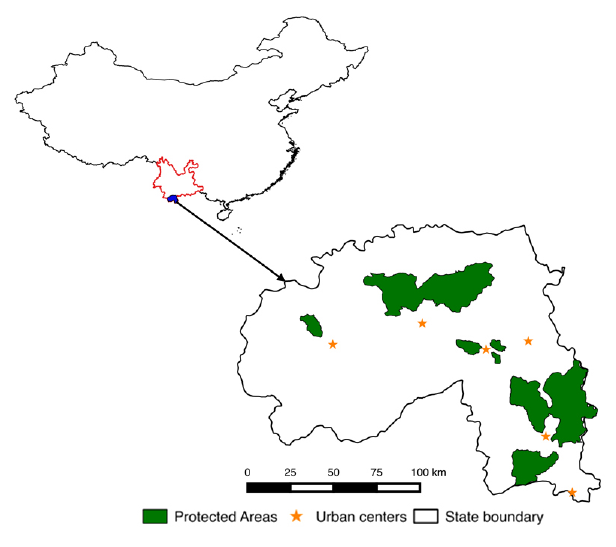
Fig. 1 . A map of Xishuangbanna Dai Autonomous Prefecture (inset; henceforth, Xishuangbanna). In the top figure, Yunnan Province is shown with a red border,x and Xishuangbanna is filled in dark blue. In the inset map of Xishuangbanna, urban centers and protected areas are